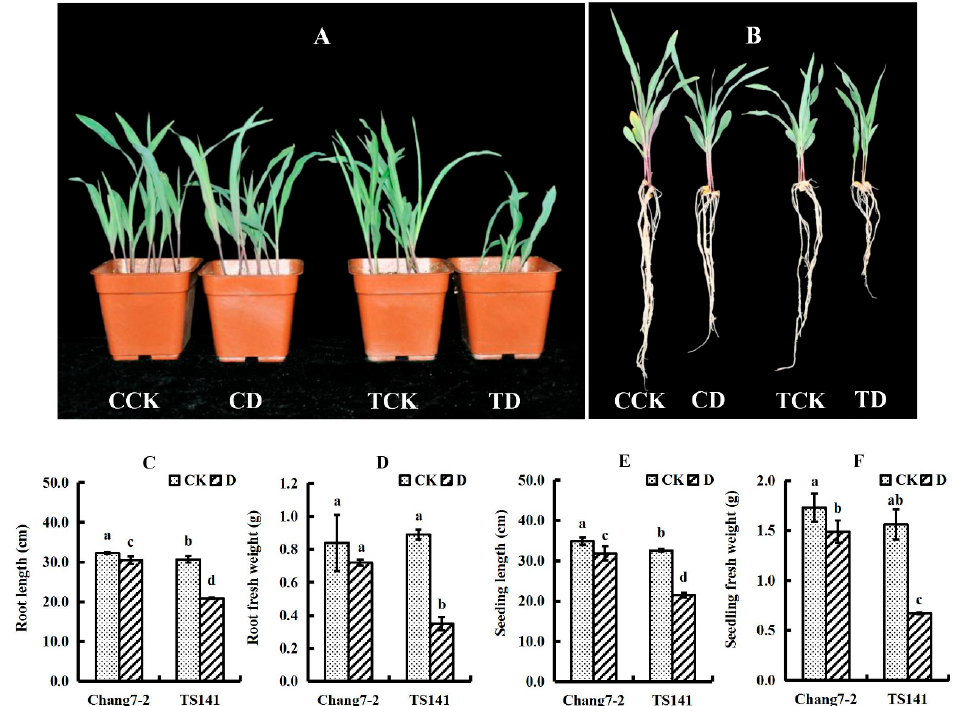
Figure 1. Growth parameters of Chang 7-2 and TS141 seedlings under control and drought-stressed conditions. Data are presented as mean ± standard deviation. Lowercase letters indicate a significant difference at the 1% level. CK: Control; D: Drought stress. CCK: Chang 7-2 control; CD: Chang 7-2 drought stress; TCK: TS141 control; TD: TS141 drought stress. (The same applies in the other tables and